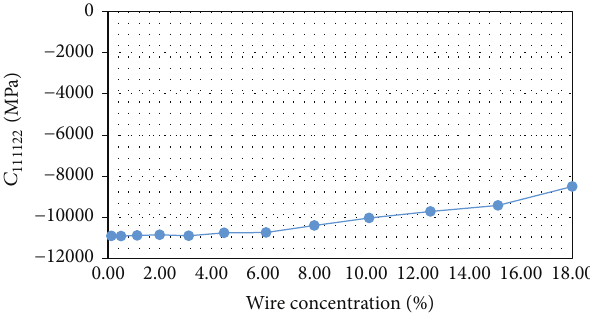
(1) 𝐶 111122 for reinforced plexiglas